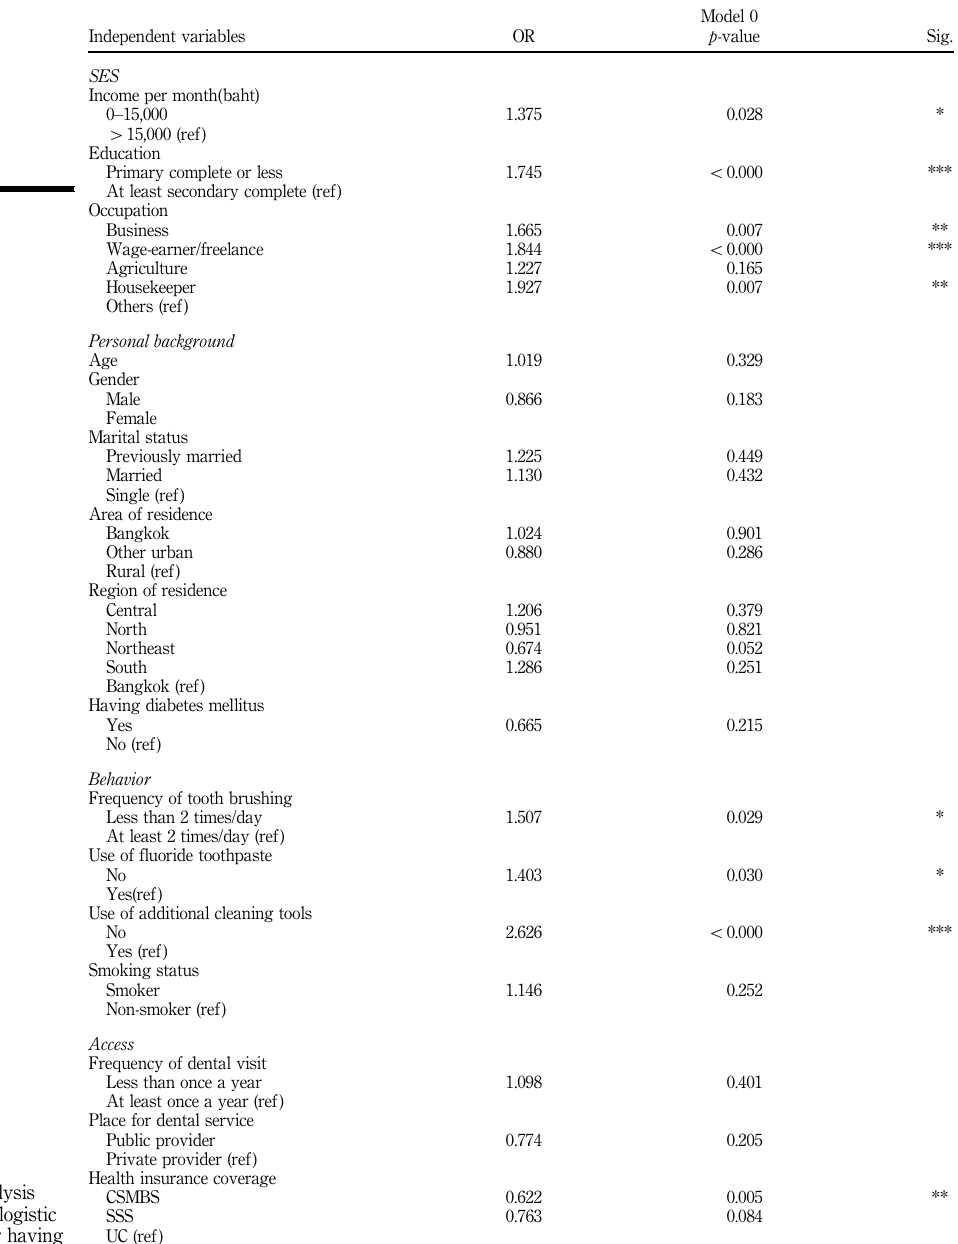
Table II. Bivariate analysis using binary logistic regression for having one or more dental caries in 35 – 44 years old age